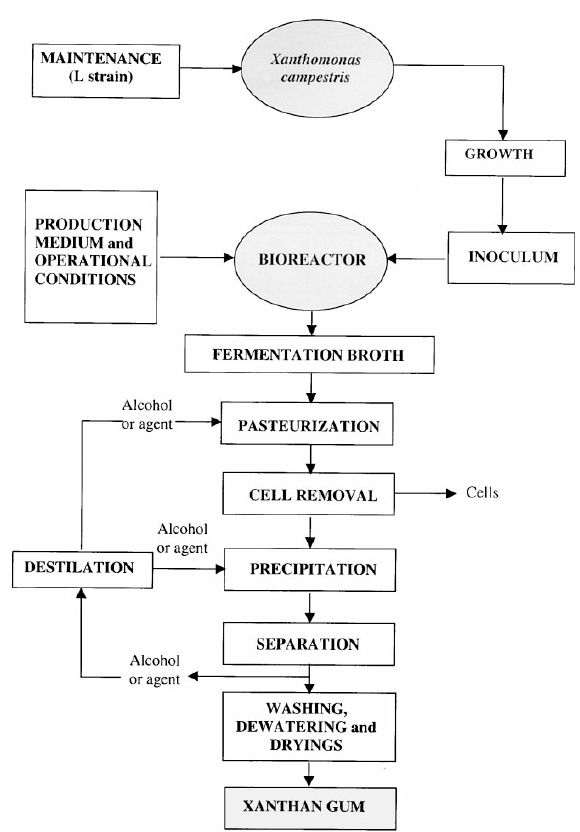
Figure 3. The production process of Xanthan gum, reproduced with permission from [10]; copyright Elsevier, 2000.